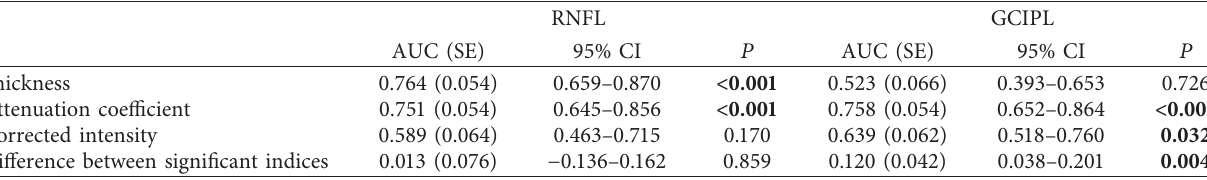
Figure 5: Receiver operating characteristic curves (ROC) of the thickness, the attenuation coefficient, and the corrected intensity index in the overall RNFL and GCIPL (expressed as TRNFL and TGCIPL, ARNFL and AGCIPL, and IRNFL and IGCIPL, respectively). Table 2: Comparison of the areas under the receiver operating characteristic curves (AUCs) between the